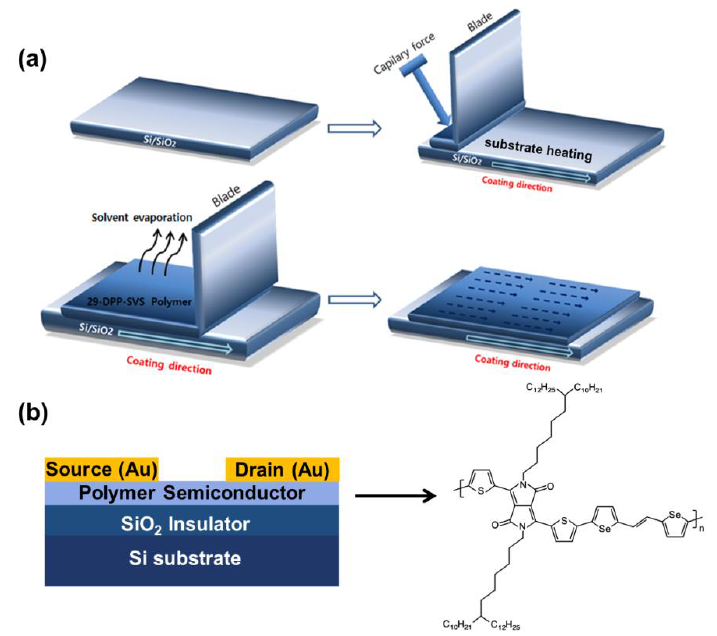
Figure 1. ( a ) Flow chart of the 29-diketopyrrolopyrrole-selenophene vinylene selenophene (29-DPP-SVS) polymer film fabrication process via blade-coating on a large area Si / SiO 2 substrate. ( b ) Cross-section of the thin-film transistors (TFT) (staggered bottom gate structure) and chemical structure of 29-DPP-SVS polymers.